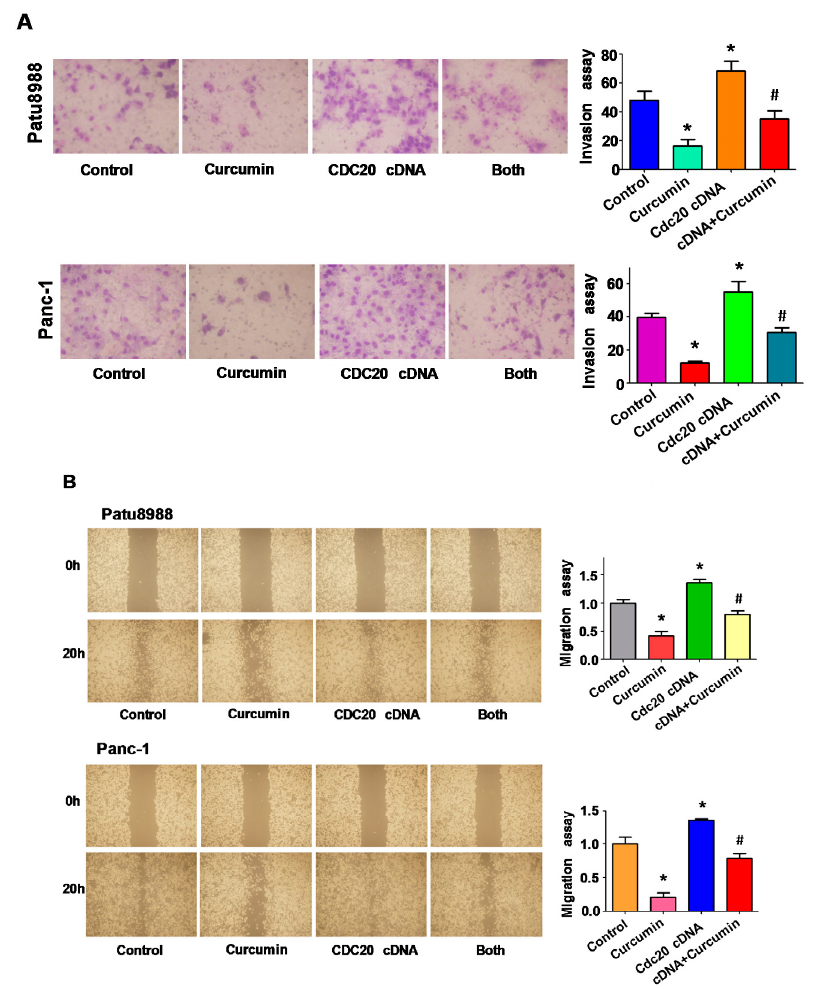
Figure 3. Overexpression of Cdc20 retarded curcumin ‐ mediated cell motility inhibition. ( A ) Left panel, invasion assay was conducted in PC cells after Cdc20 cDNA transfection and curcumin treatment. Right panel, quantitative results are illustrated for left panel. * p < 0.05, compared with control; # p < 0.05 compared with curcumin treatment or Cdc20 cDNA transfection alone; ( B ) Left panel, the wound healing assay was performed to measure the cell migration in PC cells after Cdc20 cDNA transfection and curcumin treatment. Both: Cdc20 CDNA + curcumin. Right panel, quantitative results are illustrated for left panel. * p < 0.05, compared with control; # p < 0.05 compared with curcumin treatment or Cdc20 cDNA transfection alone.